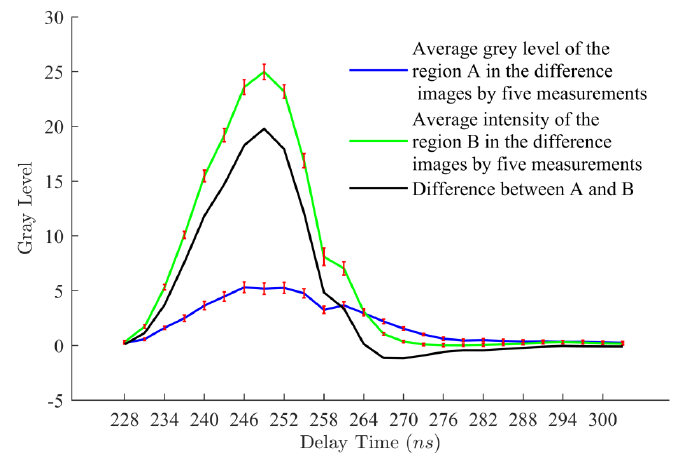
Figure 5. Averaged grey value of area A (blue) and B (green) in the intensity difference image at different delay time in five measurements. The black curve represents the grey value difference between area A and area